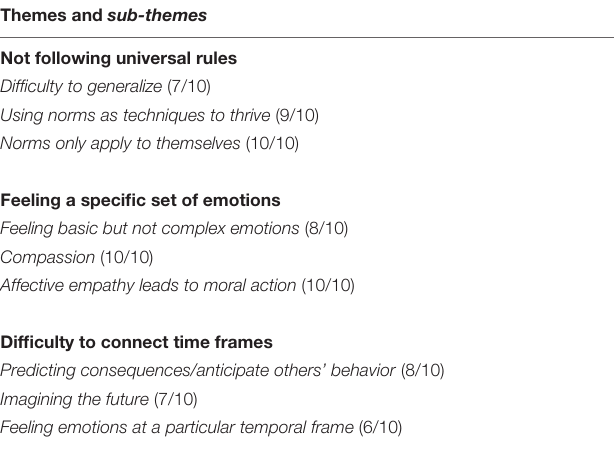
TABLE 2 | Themes and sub-themes (plus the number of authors that identified the